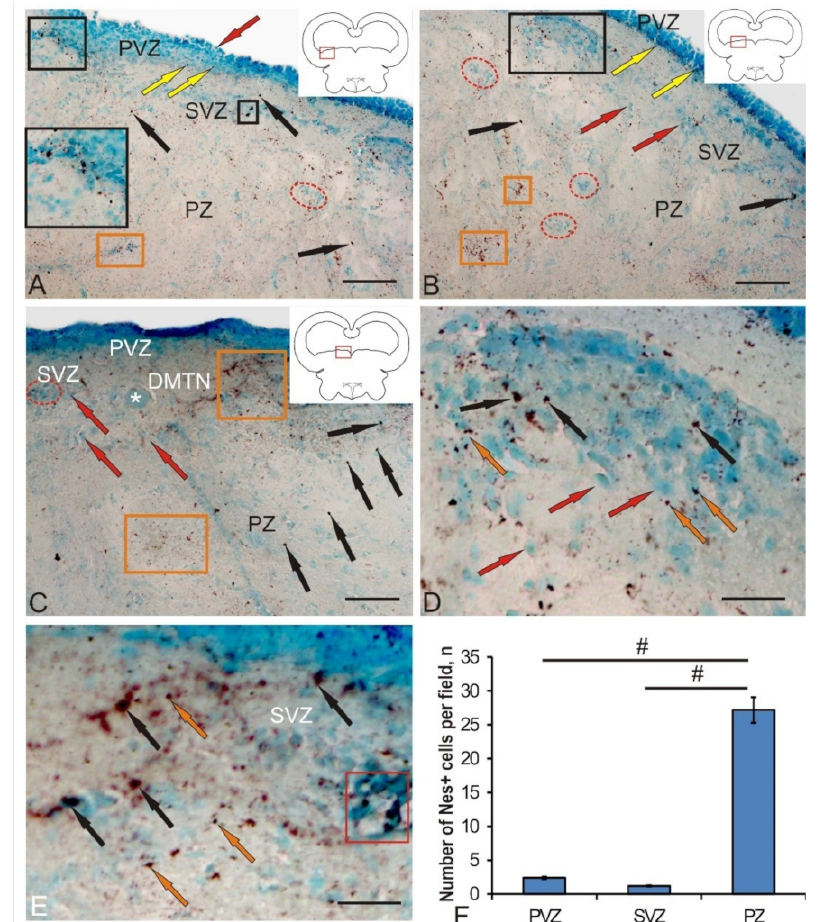
Figure 3. Localization of nestin in the mesencephalic tegmentum of juvenile chum salmon, Oncorhynchus keta . ( A ) In the lateral tegmentum: Nes + cells (black arrows), Nes + granules (yellow arrows), and Nes– cells (red arrow); an accumulation of Nes + cells and granules in the PVZ is outlined by black square (inset); constitutive Nes– neurogenic niches (in red dashed ovals) and extracellular deposition of Nes + granules (in orange rectangles). ( B ) In the dorsal tegmentum; for designations, see Figure 3A. ( C ) In the medial tegmentum: dorso-melial nuclei (DMTN) of the tegmentum; large motoneurons are indicated by a white asterisk. ( D ) An enlarged fragment containing Nes + cells and granules (inset in Figure 3 B ); Nes + granules (orange arrows). ( E ) An enlarged fragment of PZ (orange rectangle) in Figure 3 A . Immunohistochemical (IHC) nestin labeling in combination with methyl green staining. ( F ) The comparative distribution of Nes + cells in di ff erent areas of tegmentum in control groups ( n = 5 in each group; # are significant intergroup di ff erences); one-way analysis of variance (ANOVA). Scale bar: (A–C) = 100 µ m; (D,E) = 50 µ